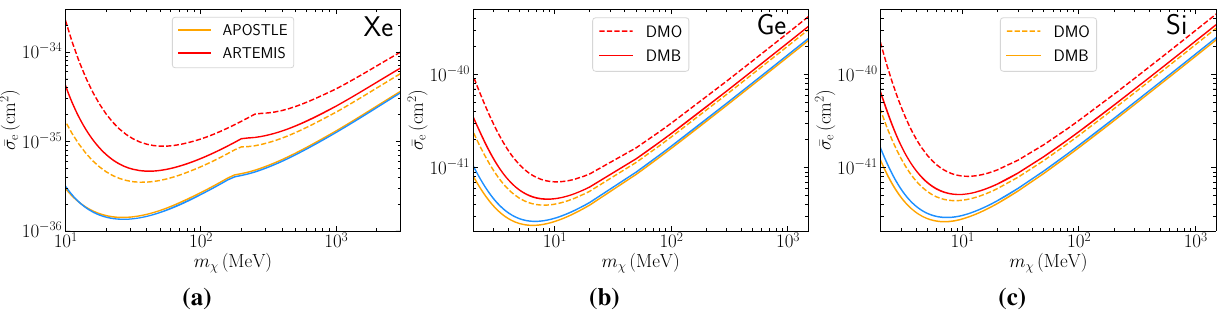
Fig. 7 Shifts in the exclusion limits for the standard halo model with F DM ∝ q − 1 for the best fit values of the different cosmological simulations. The other relevant details are same as of Fig. 2